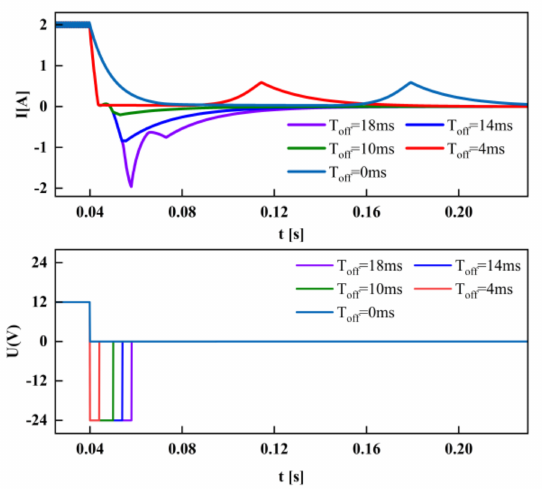
Figure 13. Simulated dynamic responses of the coil current under different switching times (T off ) in the closing process.